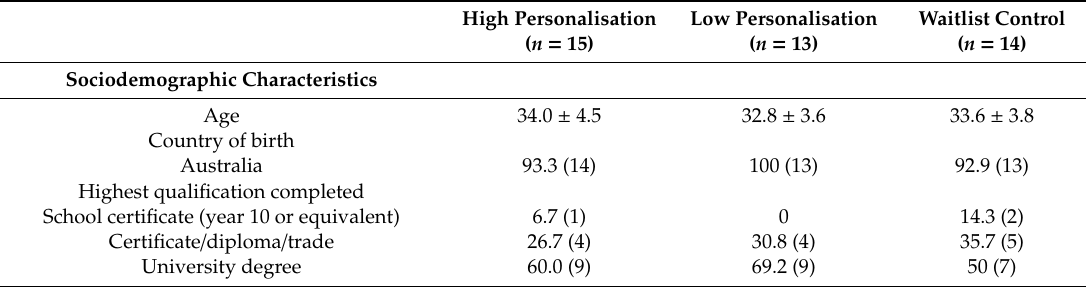
Figure 2. Consolidated Standards of Reporting Trials (CONSORT) diagram showing the flow of participants in a 6-month pilot randomised controlled trial for women with recent GDM who were at risk of developing T2DM. Table 1. Baseline characteristics of women randomised to the high personalisation, low personalisation and waitlist control groups in a 6-month pilot randomised controlled trial for women with recent GDM who were at risk of developing T2DM: data are presented as % (n) or mean ±